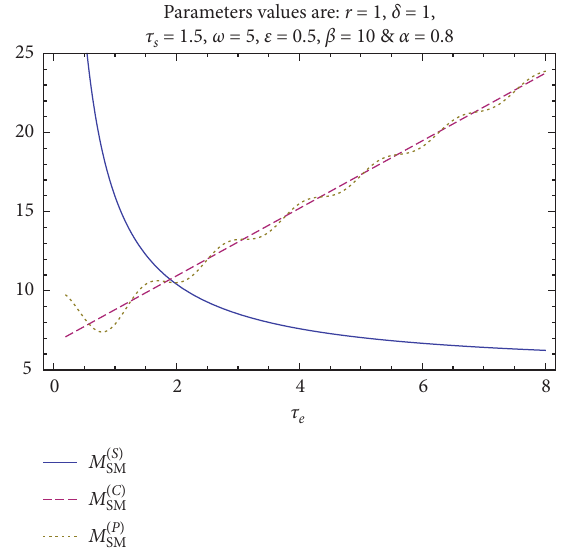
Figure 6: The total number of sterile males, relative to single, continuous, and periodic release strategies, is plotted as functions of the extinction time τ e for the intraspecific and interspecific submodels F and H 3